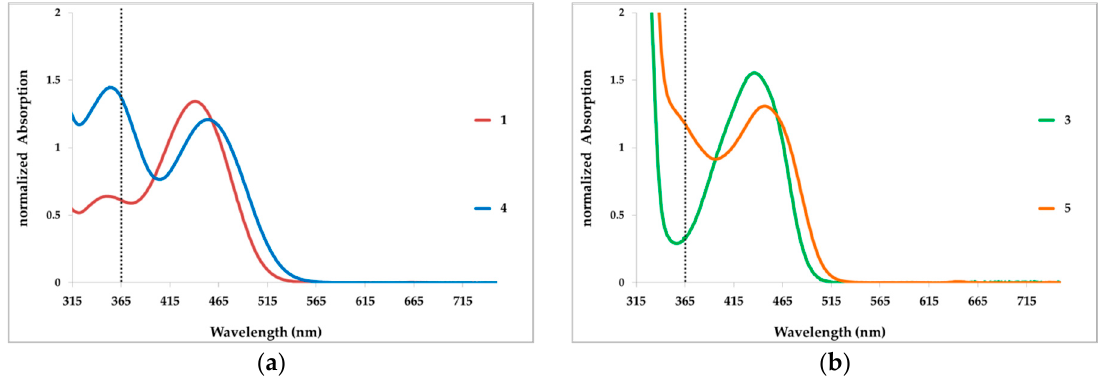
Figure 3. Normalized UV/Vis absorption spectra of compounds in DMSO. ( a ) UV/Vis absorption spectra of maleimide 1 (red line) and its caged prodrug 4 (blue line); ( b ) UV/Vis absorption spectra of carbazole 3 (green line) and its caged analogue 5 (orange line). The black dotted line in both diagrams flags 365 nm as the wavelength used for irradiation of caged compounds.